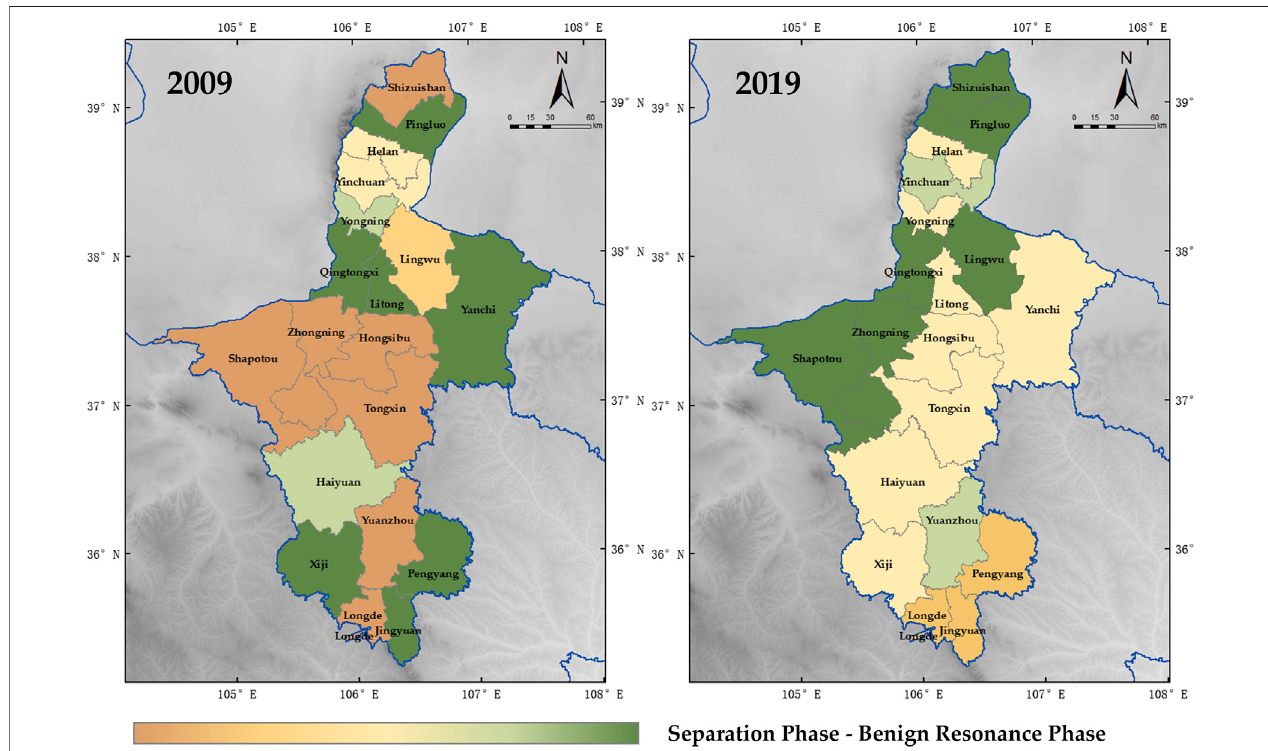
FIGURE 7 | Degree of coupling between urbanization and land use carbon emissions in Ningxia from 2009 to 2019.